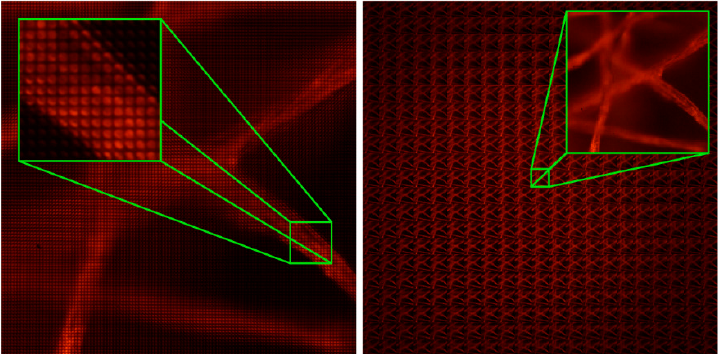
Figure 5. ( a ) Integral image registered with the IMic. The image is composed by 111 × 111 micro-images. ( b ) Set of 21 × 21 sub-images computed from ( a ).